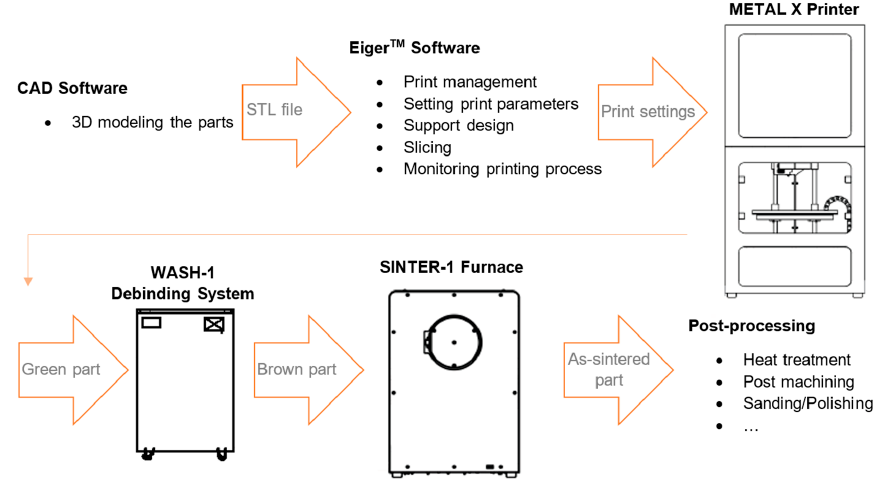
Figure 1. Utilized Markforged bound powder extrusion (BPE) metal 3D printing process [27].